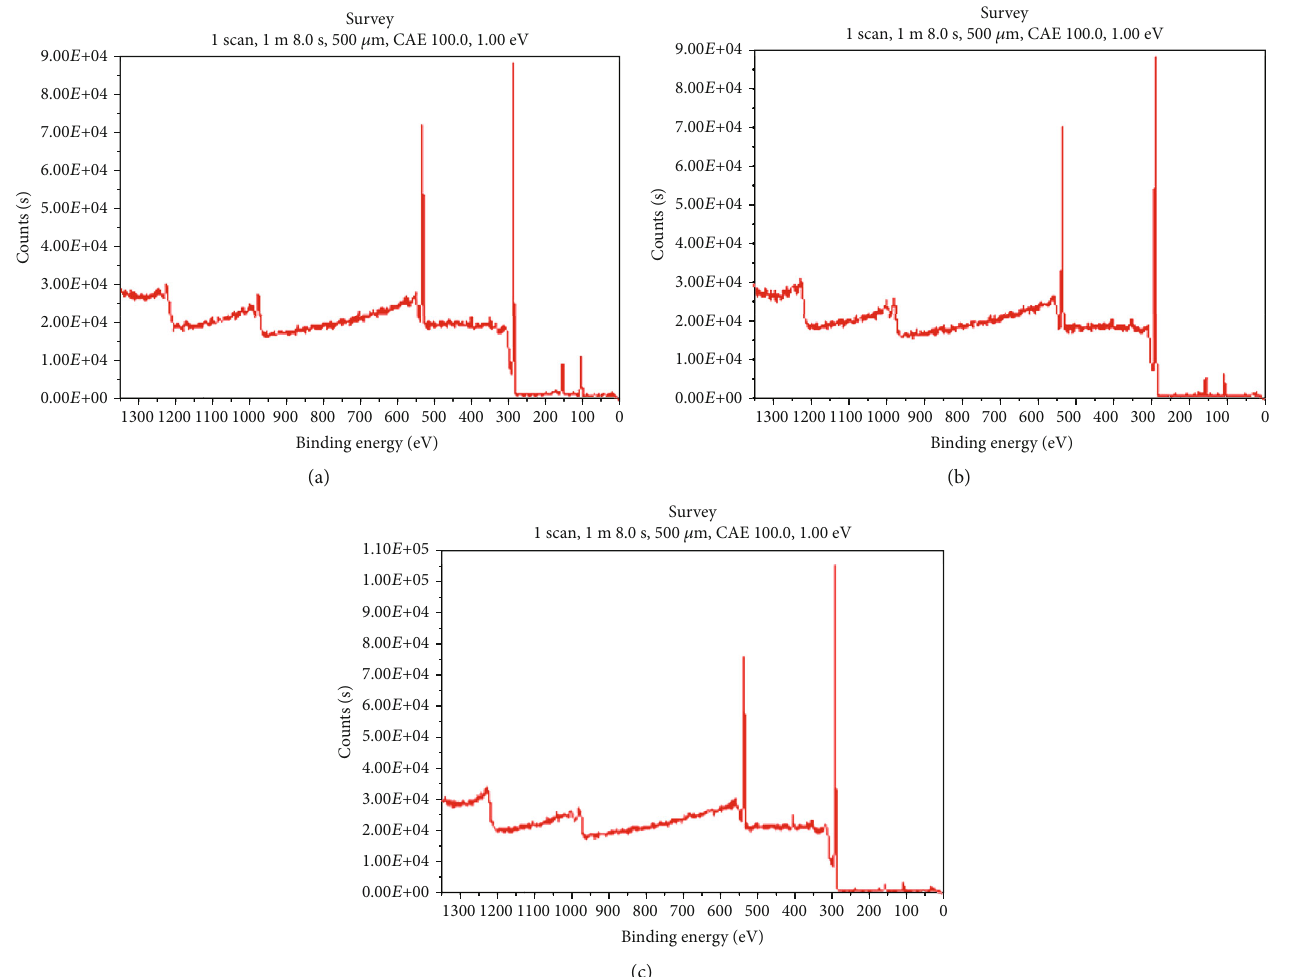
Figure 4: The XPS full-spectrum scanning results: (a) CCF800A; (b) CCF800B; (c)